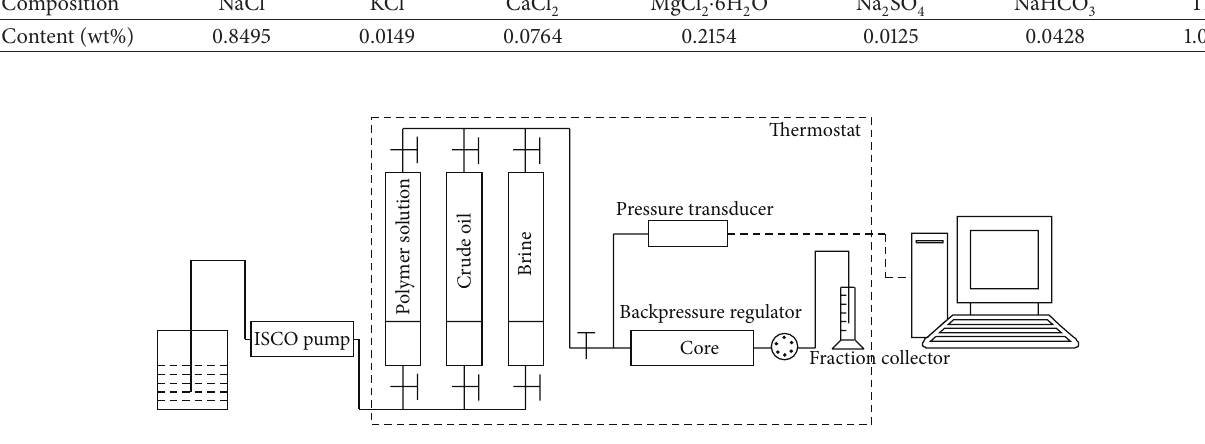
Figure 1: Flow chart of the core flooding experiments.